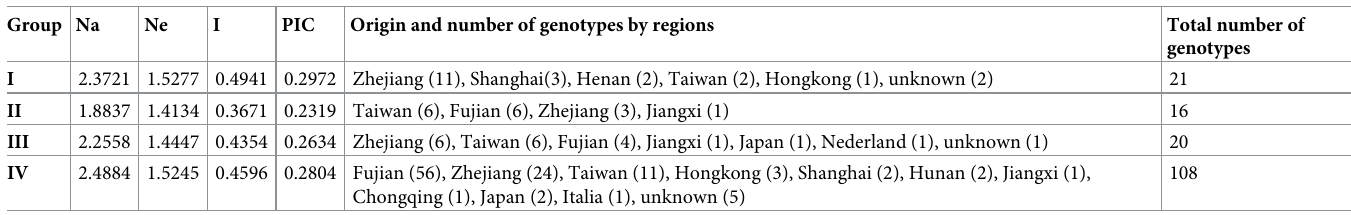
Table 1. The number of alleles (Na), effective number of alleles (Ne), Shannon’s Information index (I) and polymorphism information content (PIC) of four groups estimated by 43 SSR markers. Group Na